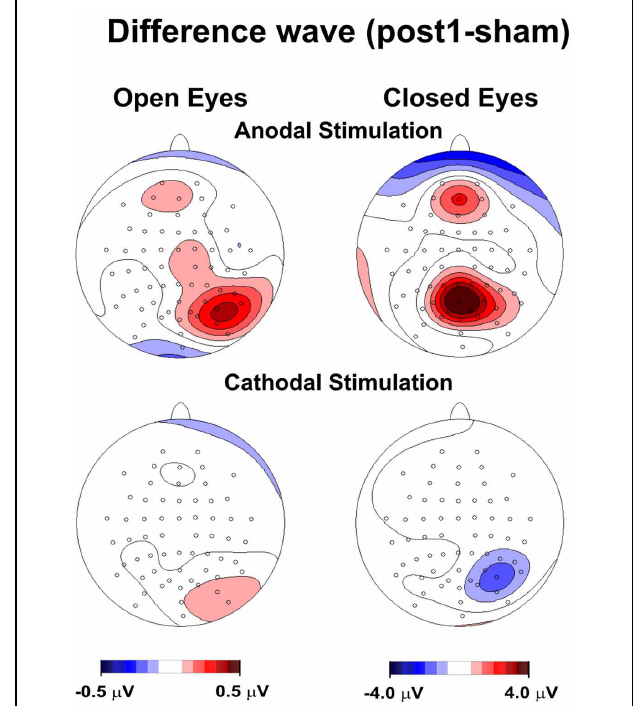
FIGURE 1 | Topography of the effect of tDCS for open and closed eyes and anodal and cathodal stimulation. The maps were obtained by subtracting the sham condition from